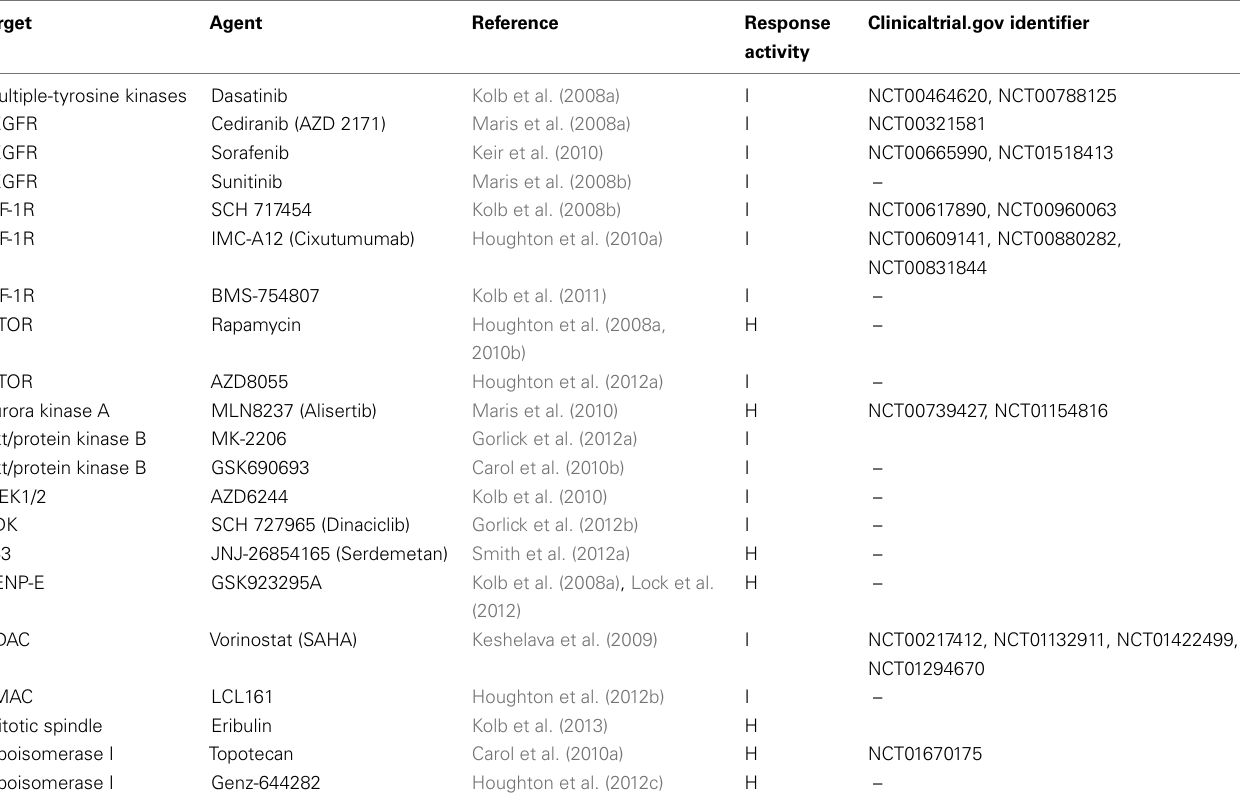
Table 1 |Agents tested by the PPTP with high (H) and intermediate (I) activities in osteosarcoma xenografts and corresponding clinical trials that include pediatric patients with osteosarcoma.